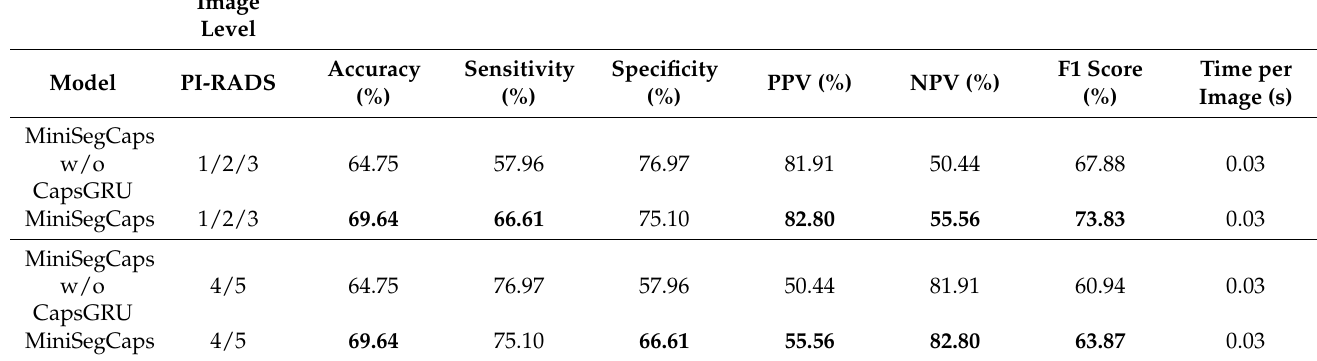
Table 11. Comparison of the image-level performance between our method and baseline methods in PI-RADS classification of prostate cancer.